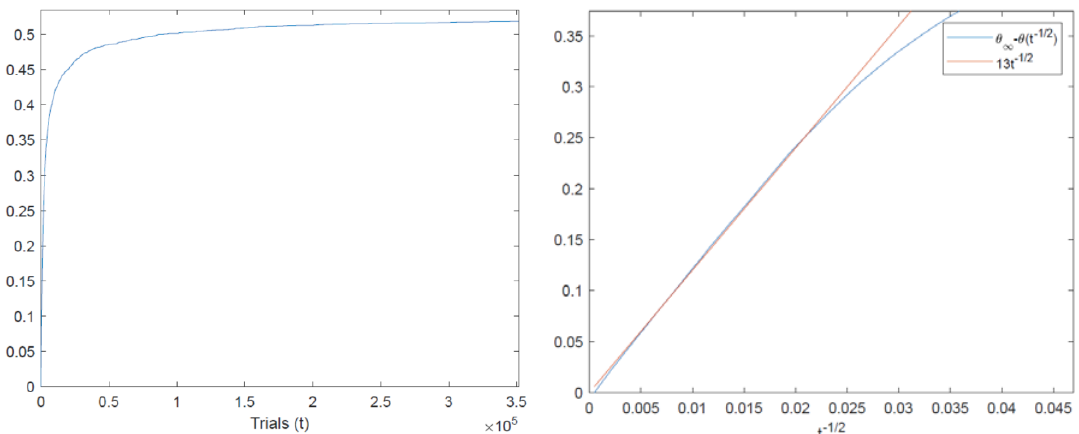
Figure 8. Density θ ( t ) of occupied area as a function of trials ( left ) and highlighting of the power law behaviour of θ ∞ − θ ( t ) for large values of t ( right